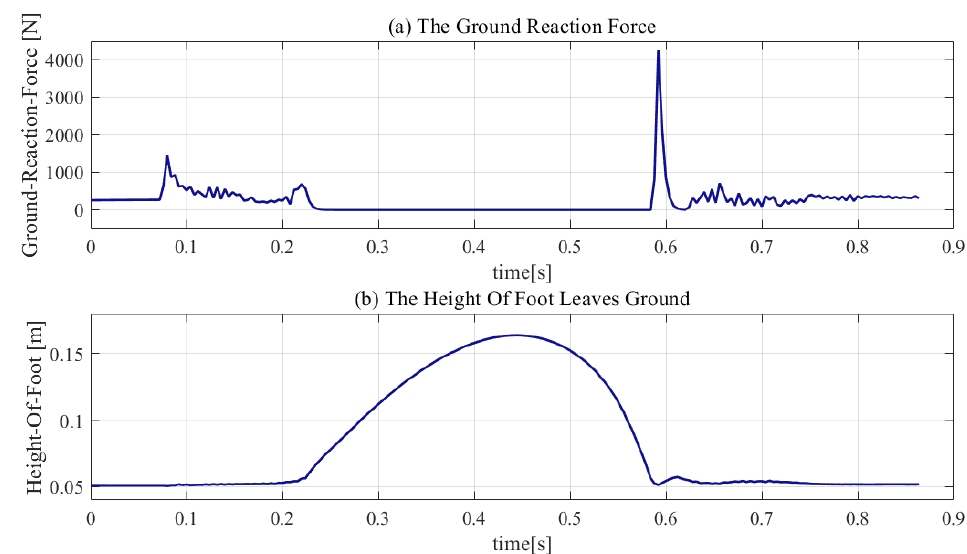
Figure 8. Reaction force and height of foot.